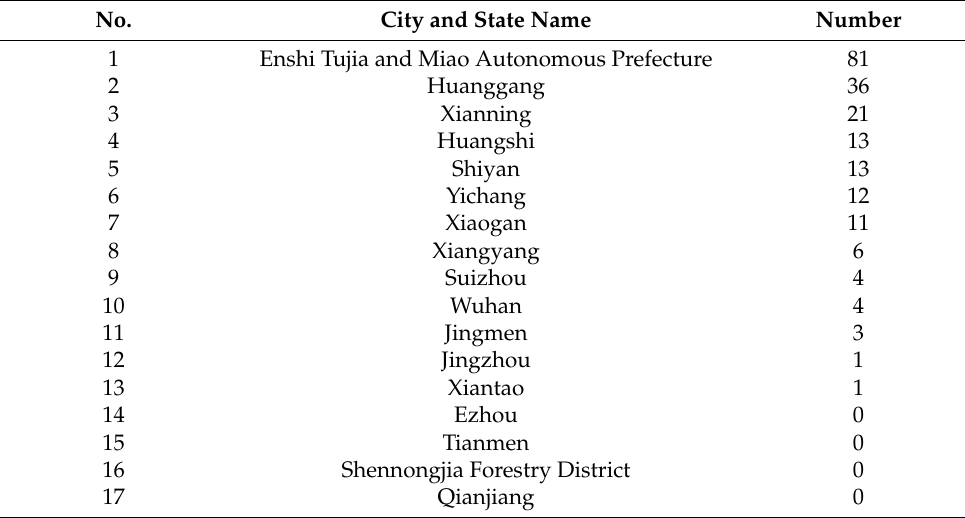
Table 1. The number of traditional villages in cities and prefectures in Hubei. No. City and State